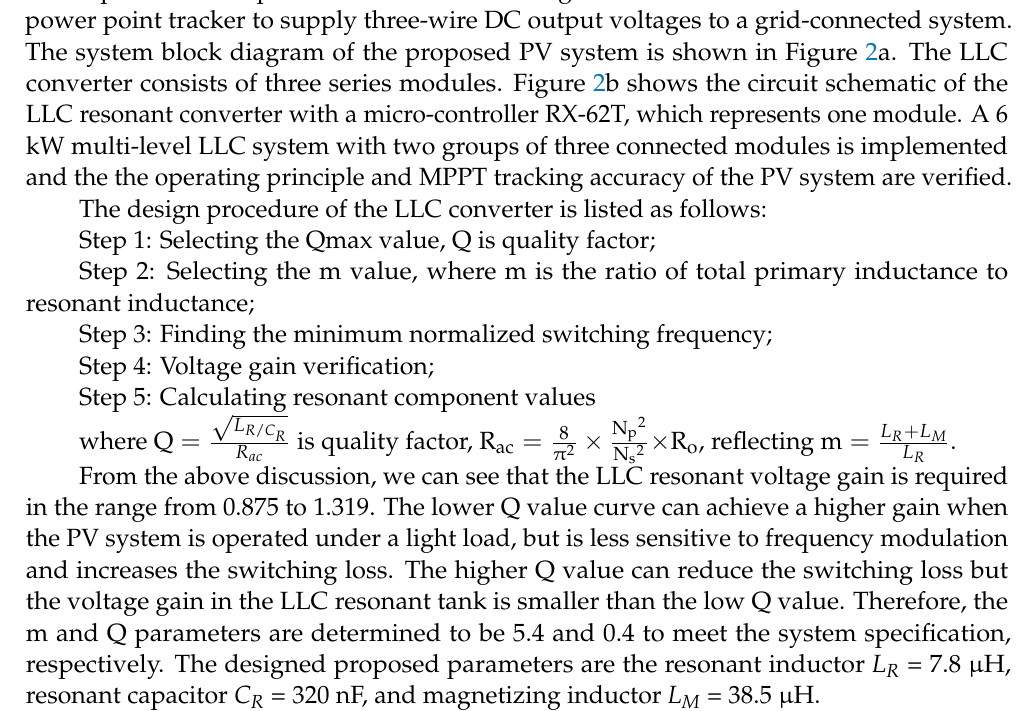
Figure 4. V-I curve and P-I curve under shading conditions. 3.1. Global Maximum Power Scan (GMPS) P&O is a highly simple technique to vary a desired step in the duty cycle, so the solar panel’s voltage and current will change. Then, the previous data and data after perturba- tion are compared. The P&O parameter is the switching frequency of the LLC converter to vary the converter gain and achieve MPPT. The P-V curve caused by the changing fre- quency method is shown in Figure 5. Firstly, we measured and compared the previous voltage and current values and the ones after perturbation. Secondly, we determined the next switching frequency of the LLC converter to increase the output power of the PV system. Freq.↑ Freq.↓P V Figure 5. The P-V curve caused by changing switching frequency. We used the global maximum power scan method to reach the global maximum power point (GMPP) for the proposed PV system. By changing the switch frequency of the LLC Dc/Dc converter, we measured the power values of the solar panel when the LLC converter was operated from a low frequency to a high frequency. Therefore, the P-V curve of the solar panel is measured and we can extract the GMPP of the solar array. Fig- ure 6 shows the proposed scanning method, that is, the LLC converter changes the switch- ing frequency to change its operating voltage from the voltage P 1 to P 6 . After that, we can obtain a P-V curve and find the GMPP’s location, then let the converter operate the fre- quency to obtain the MPPT voltage, and then run P&O to ensure that it can output the maximum power.